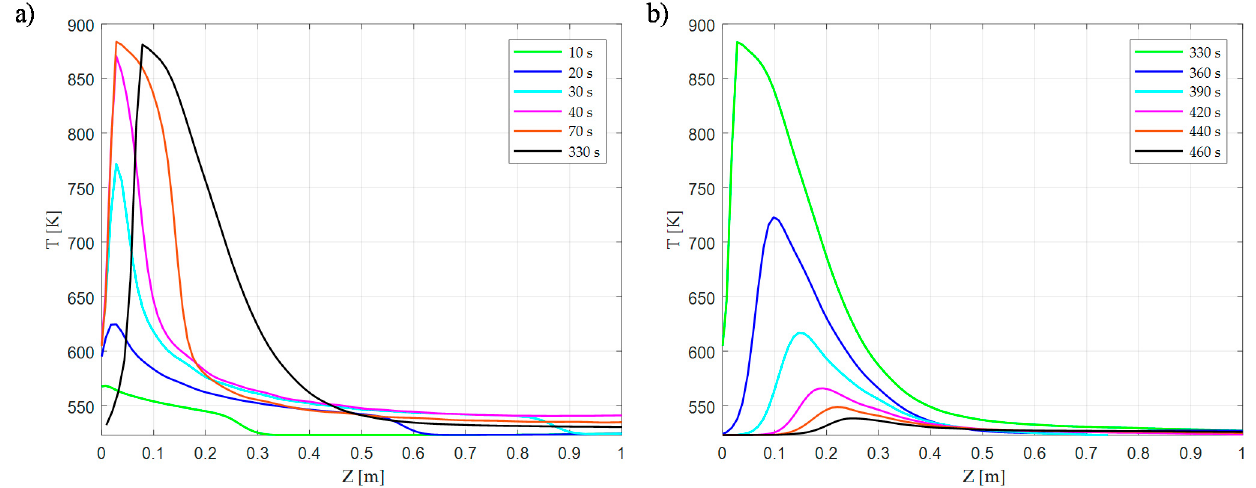
Figure 4. Transient axial temperature profiles inside reactor tubes for: ( a ) Start-up and ( b ) Shutdown operation. Steady state reached after 330 s ( a ), and reactor Shutdown reached after 130 s of H 2 feed interruption ( b ).